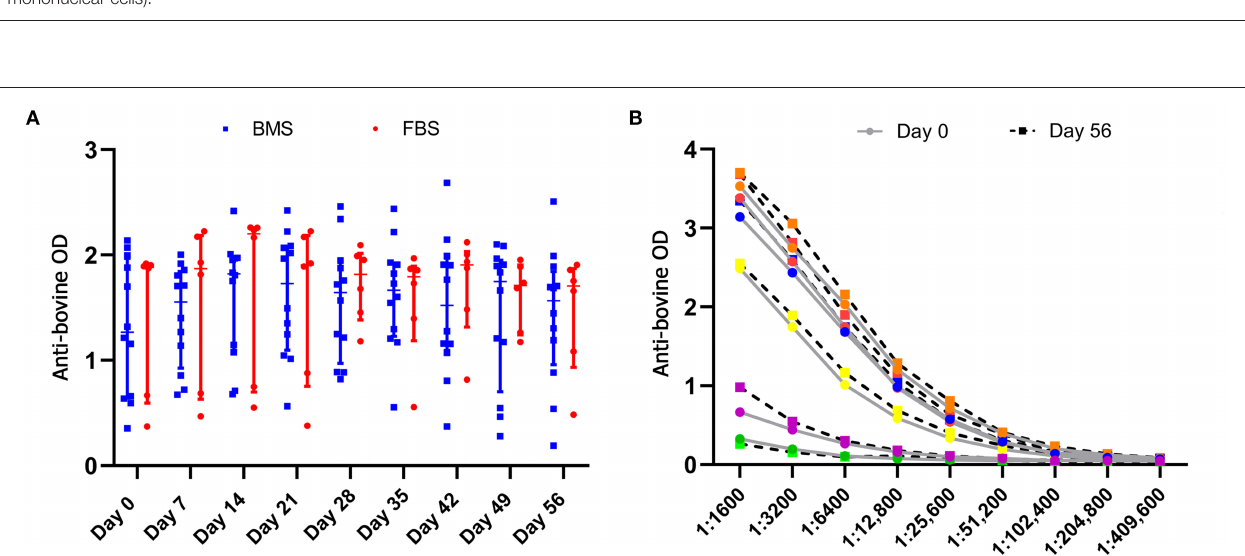
FIGURE 5 | Anti-bovine titers were present in all horses prior to MSC administration that did not change after MSC administration. (A) There were no differences in antibody concentrations, measured by optical density (OD), between groups, and antibody concentrations did not change over time. (B) There was no difference in anti-bovine titers in FBS-MSC recipients prior to and after FBS-MSC exposure. Each individual is represented by a different color.